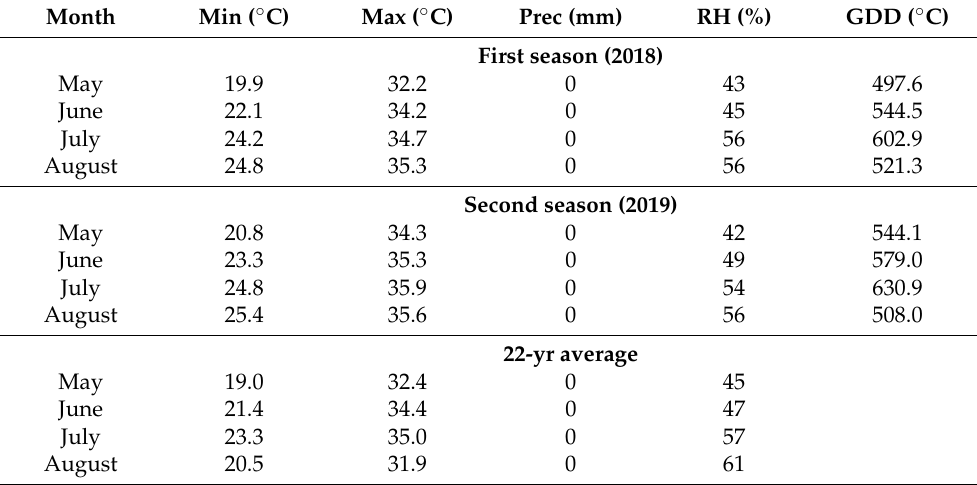
Table 1. Minimum (min) and maximum (max) temperatures, total precipitation (Prec), relative humidity (RH), and cumulative growing degree days (GDD) in 2018 and 2019 seasons as well as 22-year averages (1998–2019).